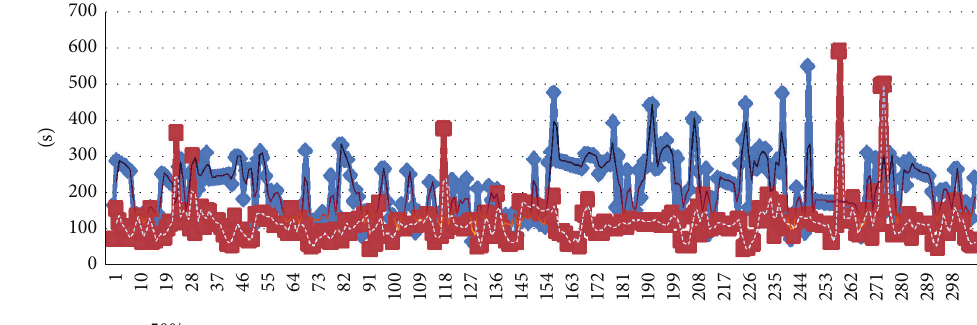
Figure 3: Comparison of average travel time under 9800 veh network loading.